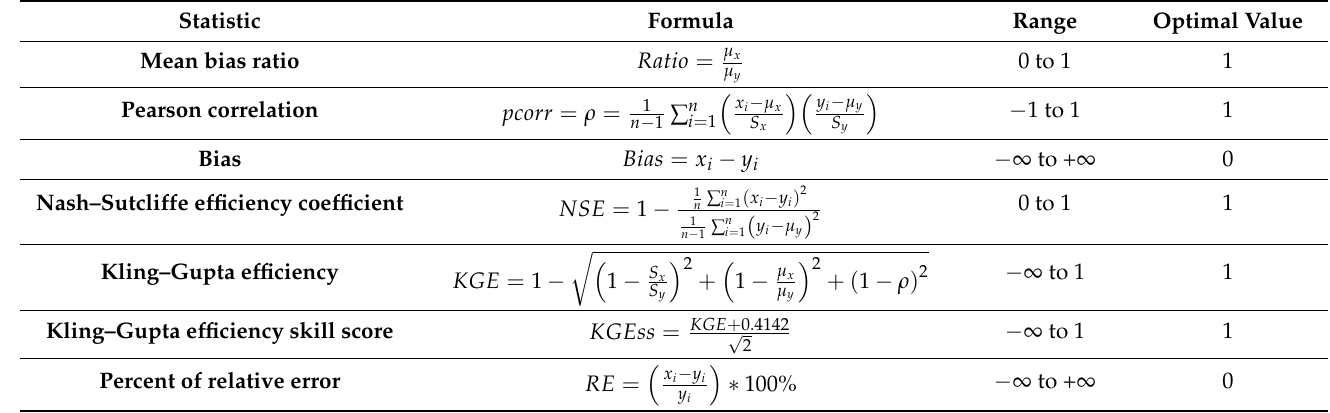
Table 3. Statistical metrics used for the evaluation of the AMS and IDF equations. x represents the IMERG values, y the gauge-based values, µ is the mean, and S is the standard